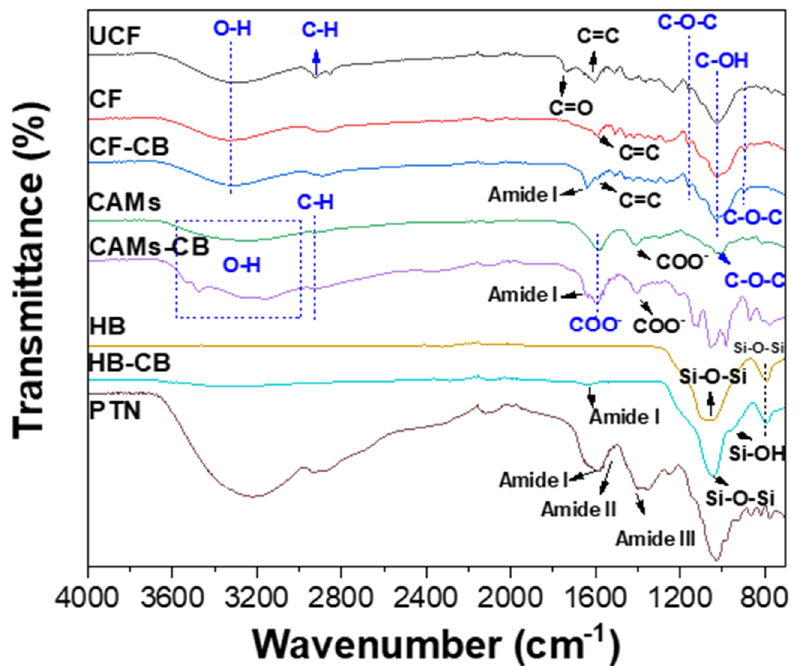
Figure 7. Fourier Transform Infrared Spectroscopy (FTIR) analysis. Supports: untreated coconut fiber (UCF), treated coconut fiber (CF), calcium alginate microspheres (CAMs) and SBA-15 / albumin hybrid (HB). Immobilized radish peroxidase by covalent binding (CB): HB-CB, CAMs-CB, CF-CB. Radish protein (PTN).